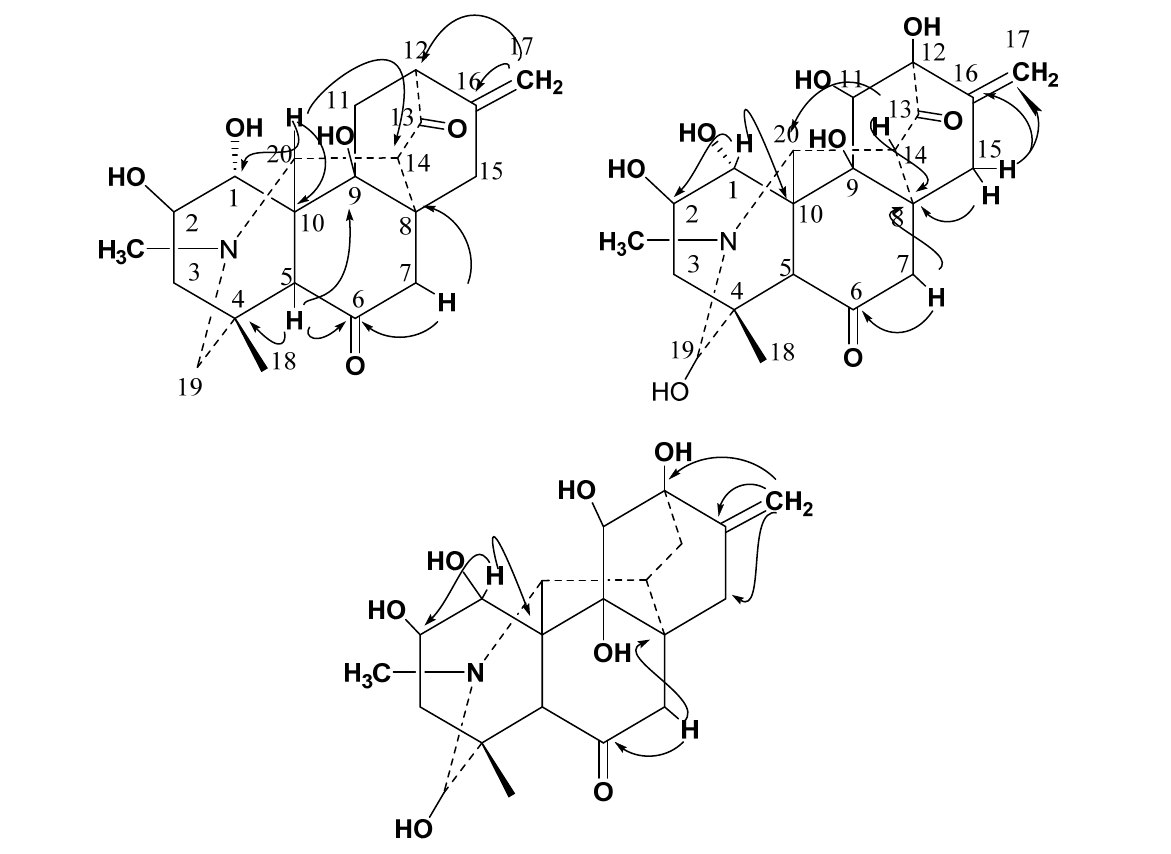
Figure 3. HMBC interaction in 1 – 3 . Table 1. 13 C NMR data of Compounds 1 – 3 in CDCl 3.